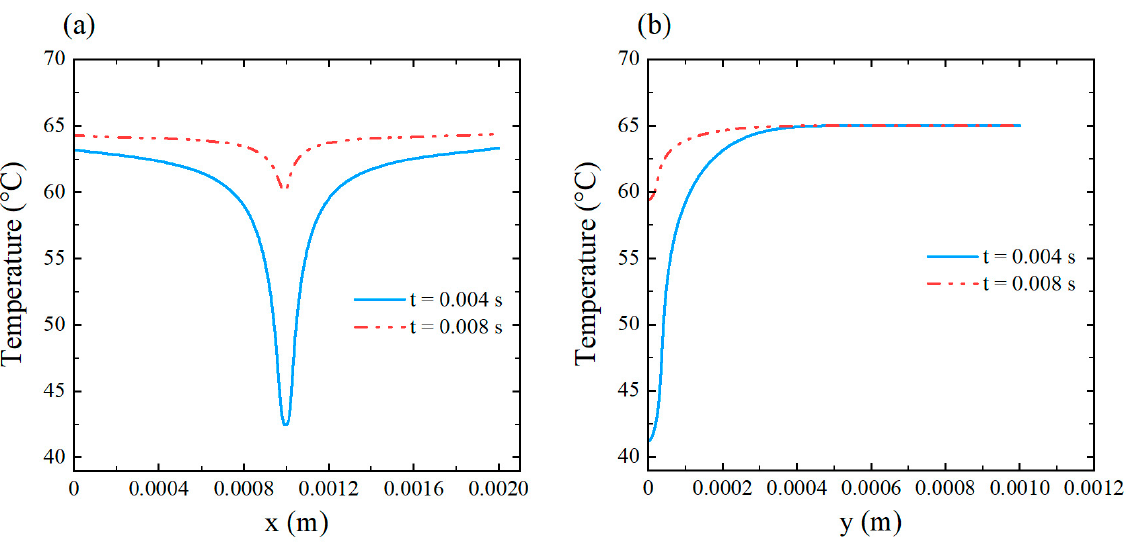
Figure 8. Distribution of temperature around the water-based ink droplet at y = 2 × 10 − 5 m ( a ) and x = 0.001 m ( b ).